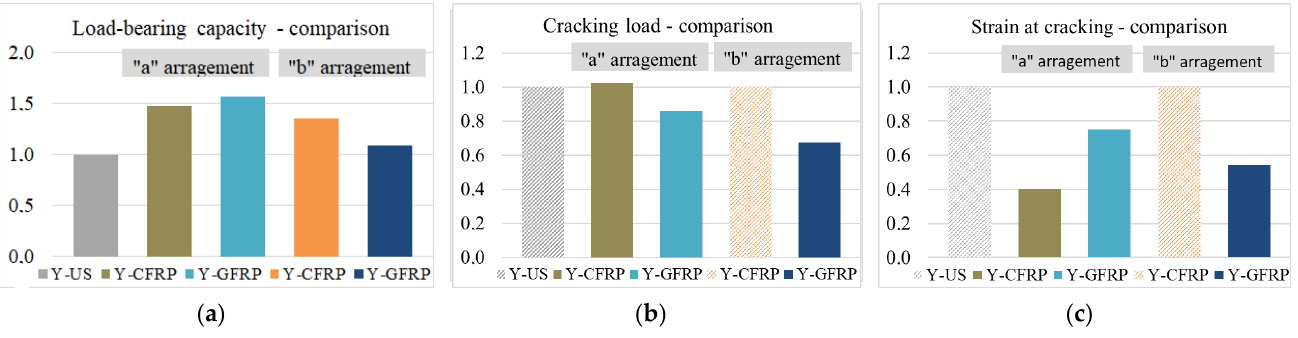
Figure 13. Relative changes in significant quantities for all tested series in a range of: ( a ) load-bearing capacity; ( b ) cracking loads; ( c ) strains at cracking.